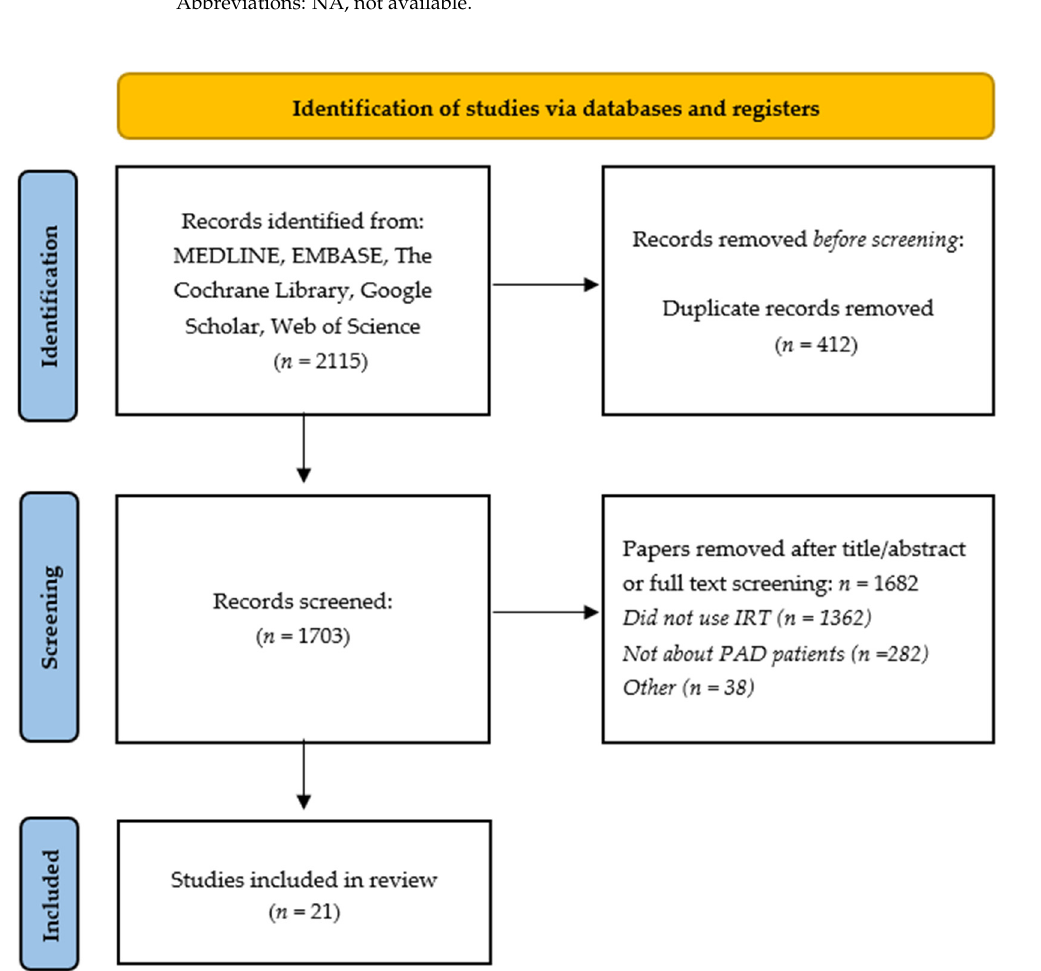
Table 1. The different models of thermography devices employed in the included studies.